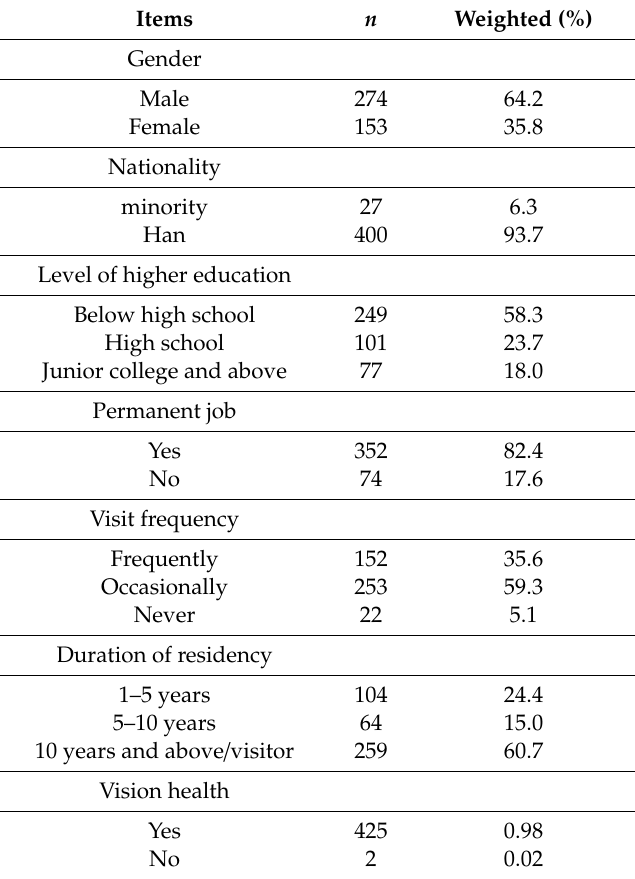
Table 1. Basic overview of the sample ( n =